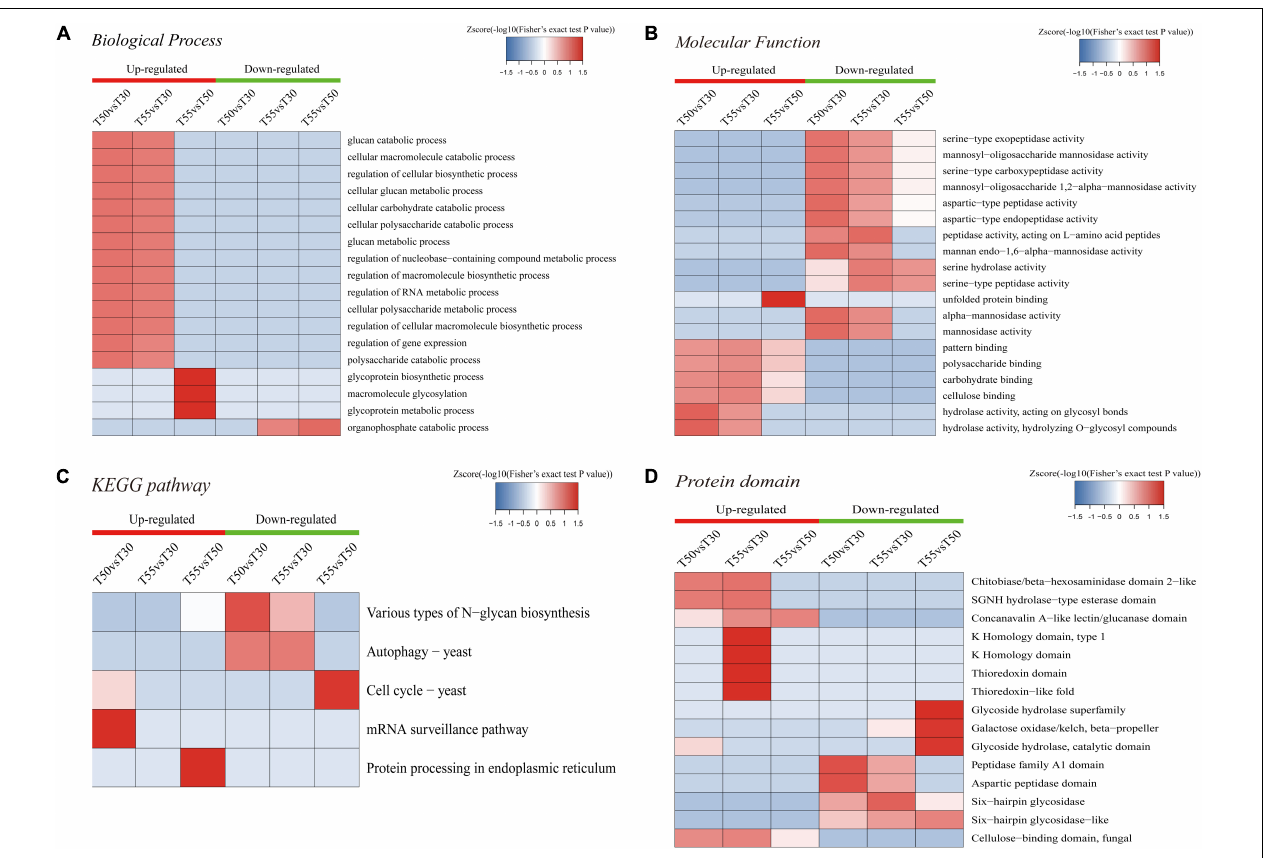
FIGURE 9 | Enrichment-based clustering analysis. (A) Biological process. (B) Molecular function. (C) KEGG pathways. (D) Protein domain.